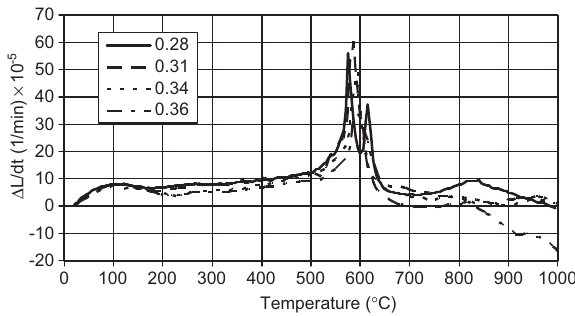
Figure 7 Thermal strain ratios of SCLC with diatomite vs. temperature. Figure 8 The first derivation of thermal strain curve of